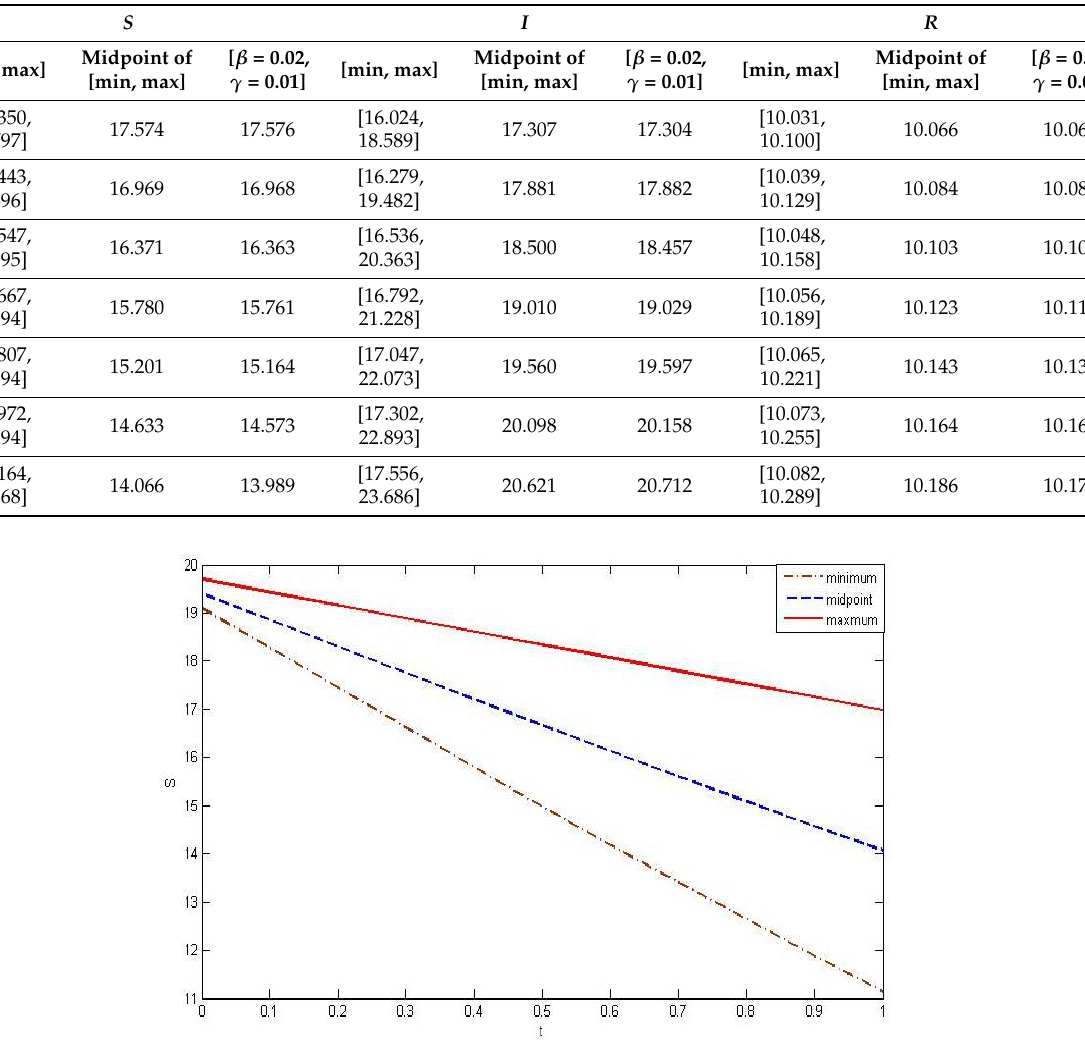
Figure A3. Plot of the maximum, center, and minimum of recovered humans under the intervals (cid:2010)(cid:3560) = [0.01,0.03] and (cid:2011)(cid:3556) = [0.01,0.015] . References 1.